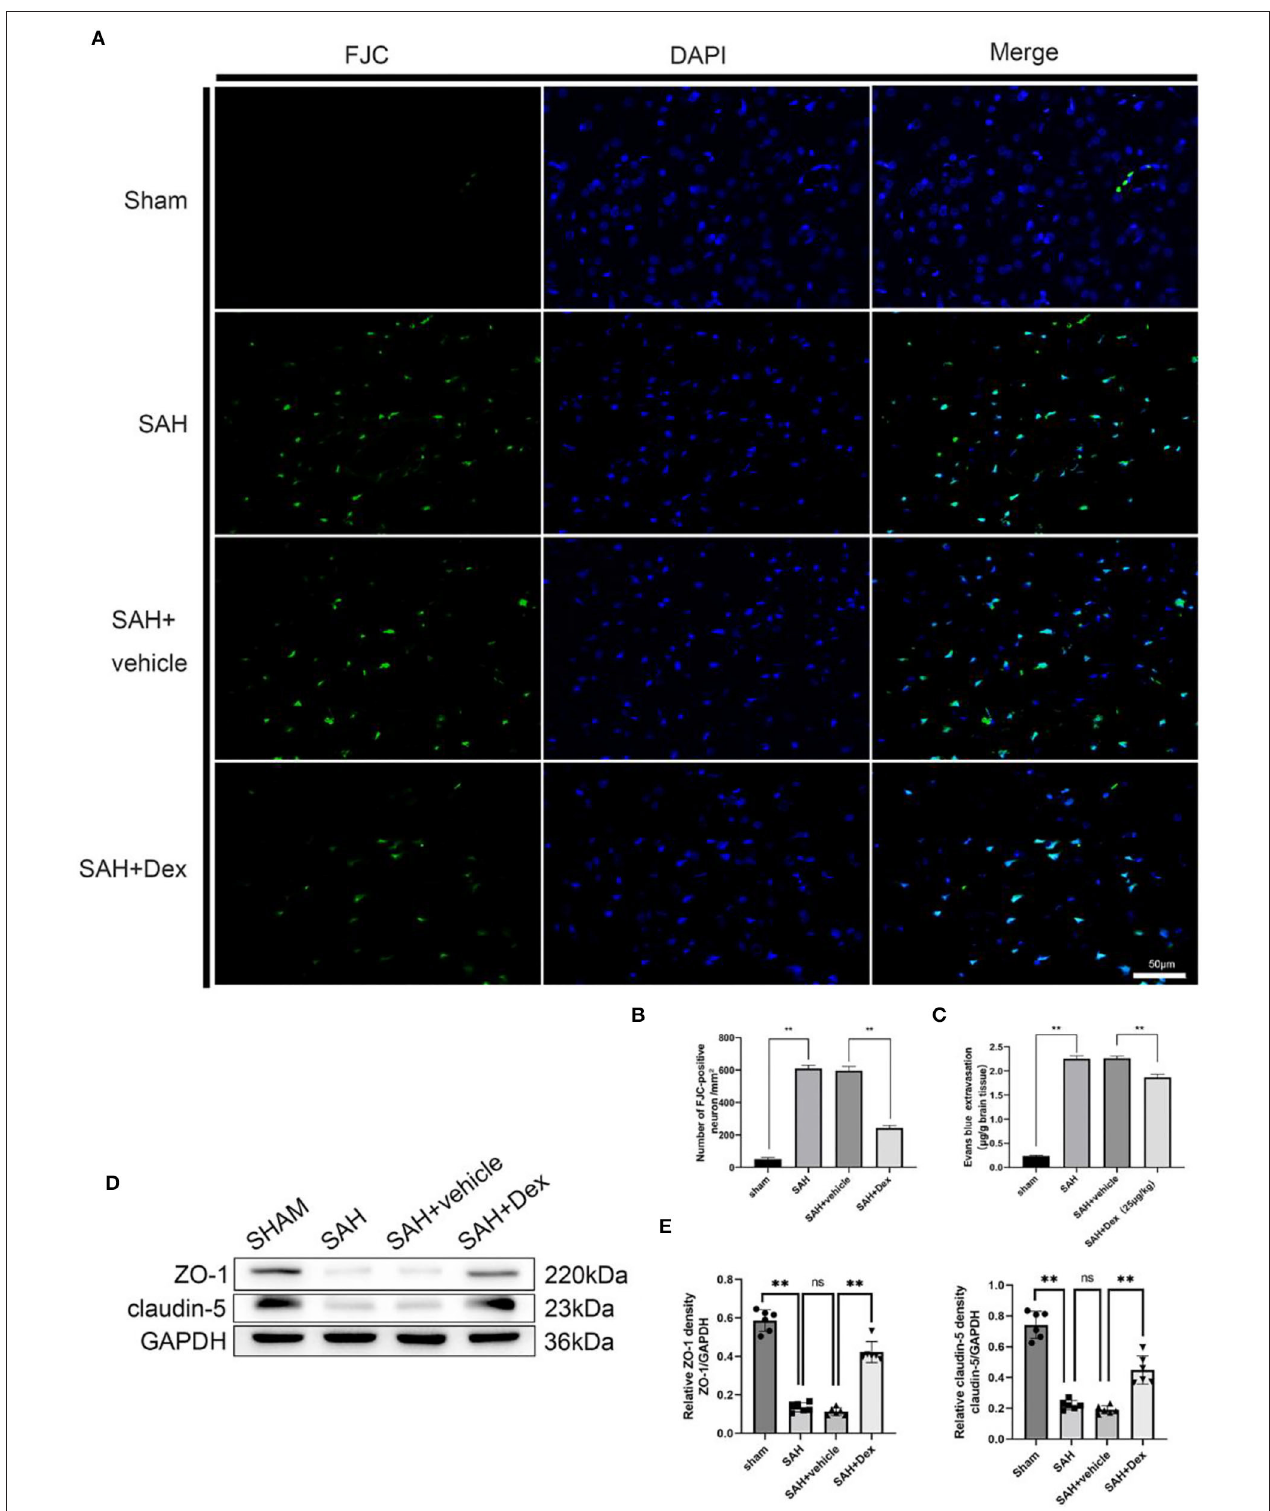
FIGURE 5 | Effects of Dex on neuronal degenerating and BBB disruption at 24h after SAH. (A) Representative microphotographs of Fluoro-Jade C staining (FJC)-positive neurons in the sham, SAH, vehicle, and dexmedetomidine groups at 24h following operation. (B) Quantitative analysis of FJC-positive cells was performed at the ipsilateral cortex. (C) Quantitative analysis of Dex administration significantly alleviated the extravasation of EB dyes. (D) Representative western blot images. (E) Quantitative analysis of western blot. n = 6 in each group. Data are expressed as mean ± SD. ** p < 0.01. Scale bar = 50 µ m.